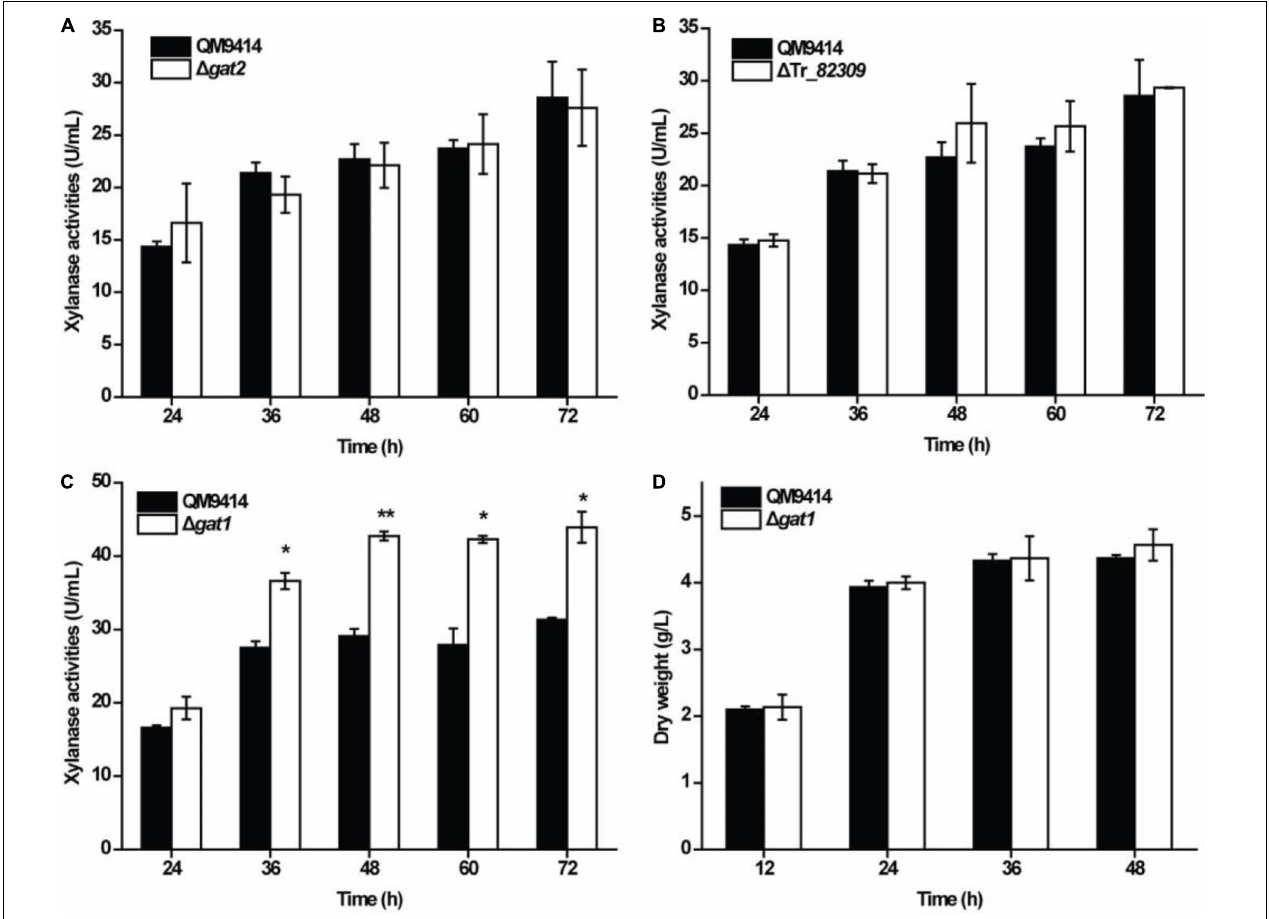
FIGURE 1 | Deletion of gat1 improved xylanase production of Trichoderma reesei on xylan. (A–C) Xylanase activity analysis of the culture supernatant from the QM9414 and mutant strains including (cid:49) gat2 (A) , (cid:49) Tr_ 82309 (B) , and (cid:49) gat1 (C) cultivated on 0.5% (w/v) xylan for the indicated time periods. (D) Growth analyses of QM9414 and (cid:49) gat1 cultured on 0.5% (w/v) xylan. Values in this figure are the mean of three biological replicates. Error bars are the SD from these replicates. Significant differences ( t -test * P < 0.05, ** P < 0.01) were detected in the extracellular xylanase activities between QM9414 and (cid:49) gat1 . No significant differences were detected in the extracellular xylanase activities of (cid:49) gat2 or (cid:49) Tr_ 82309 compared with that of QM9414. No significant differences were observed in biomass accumulation between (cid:49) gat1 and QM9414 when grown on